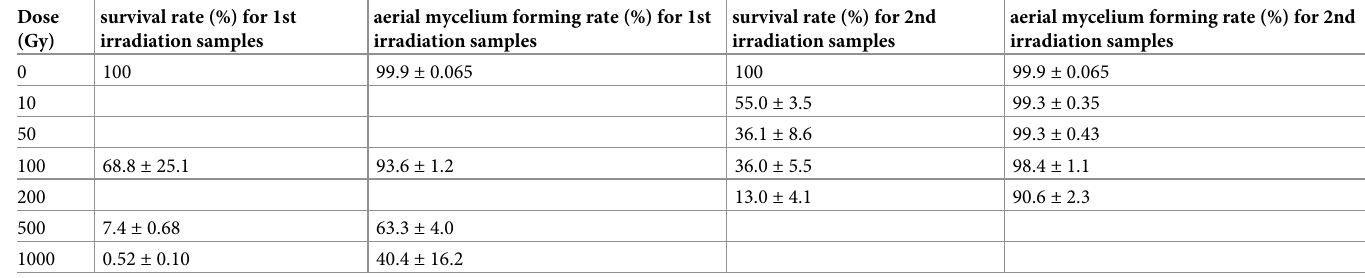
Table 1. Survival rates and aerial mycelium formation rate of the carbon ion-irradiated spores of Streptomyces coelicolor JCM4020. Dose survival rate (%) for 1st (Gy) irradiation samples